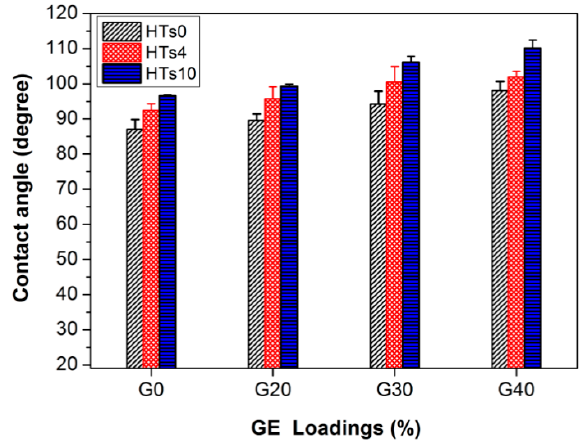
Figure10. Contact angles of FG/GE/HT composites with various HT and GE loadings.